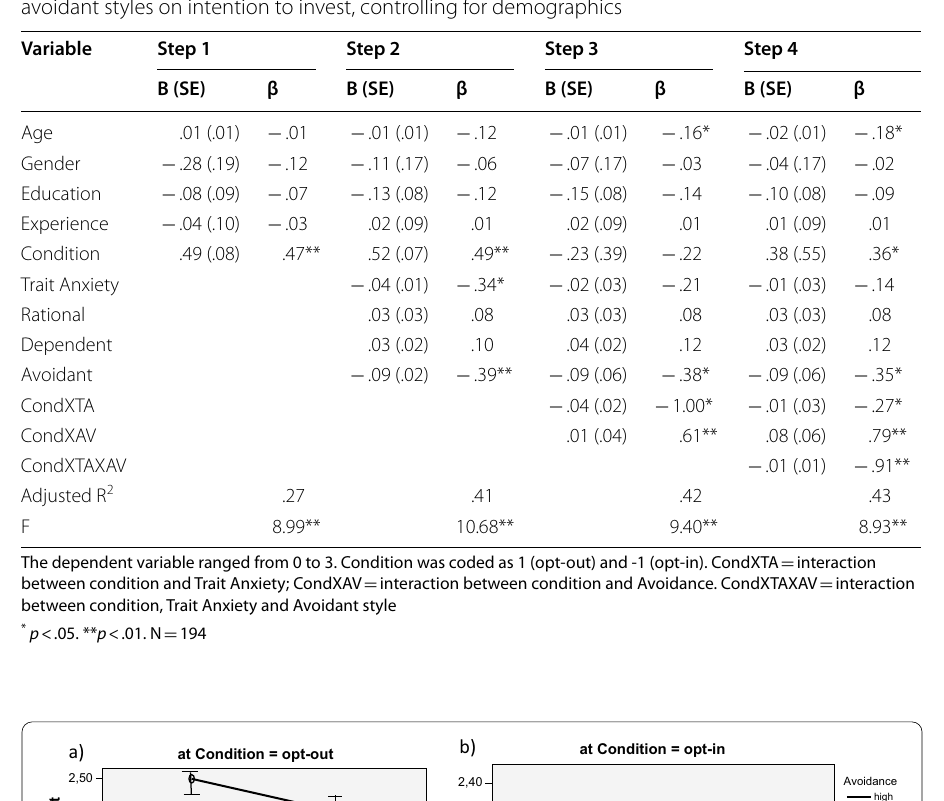
Table 6 Summary of hierarchical regression analyses for trait anxiety, rational, dependent and avoidant styles on intention to invest, controlling for demographics